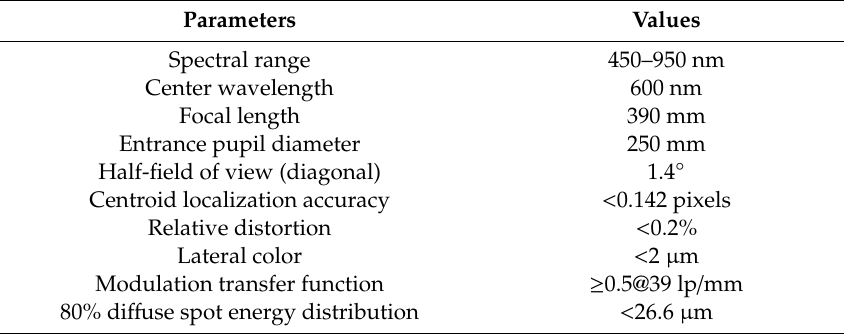
Table 3. Main design specifications of the optical